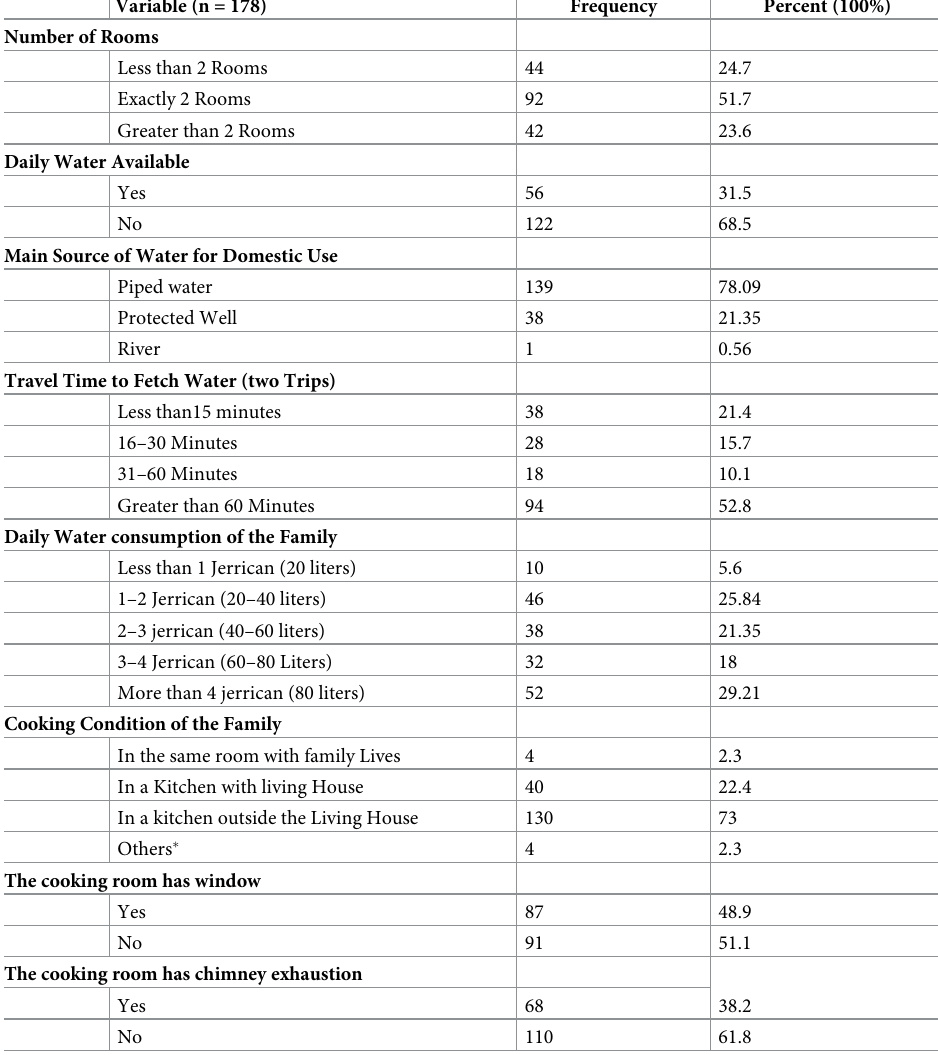
Table 2. Basic services related to active trachoma of study participants of Arsi Negele town, West Arsi Zone, Oro- mia, southern Ethiopia, December,